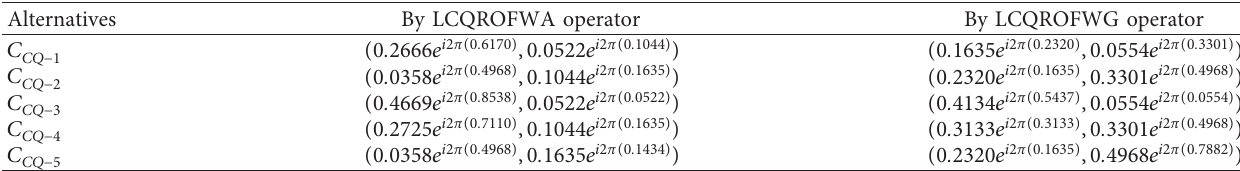
Table 6: Aggregated values by using LCQROFWA and LCQROFWG operators for Example